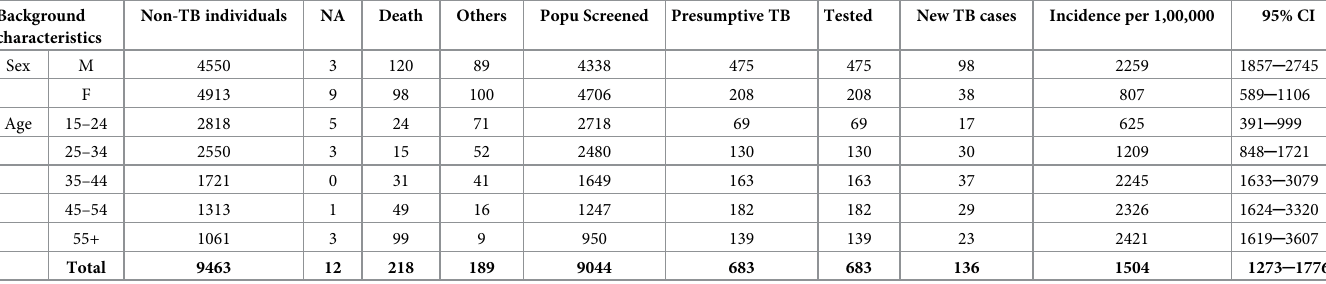
Table 2. Age-sex wise incidence of PTB (smear and/or culture positive) in the endline survey. Background characteristics